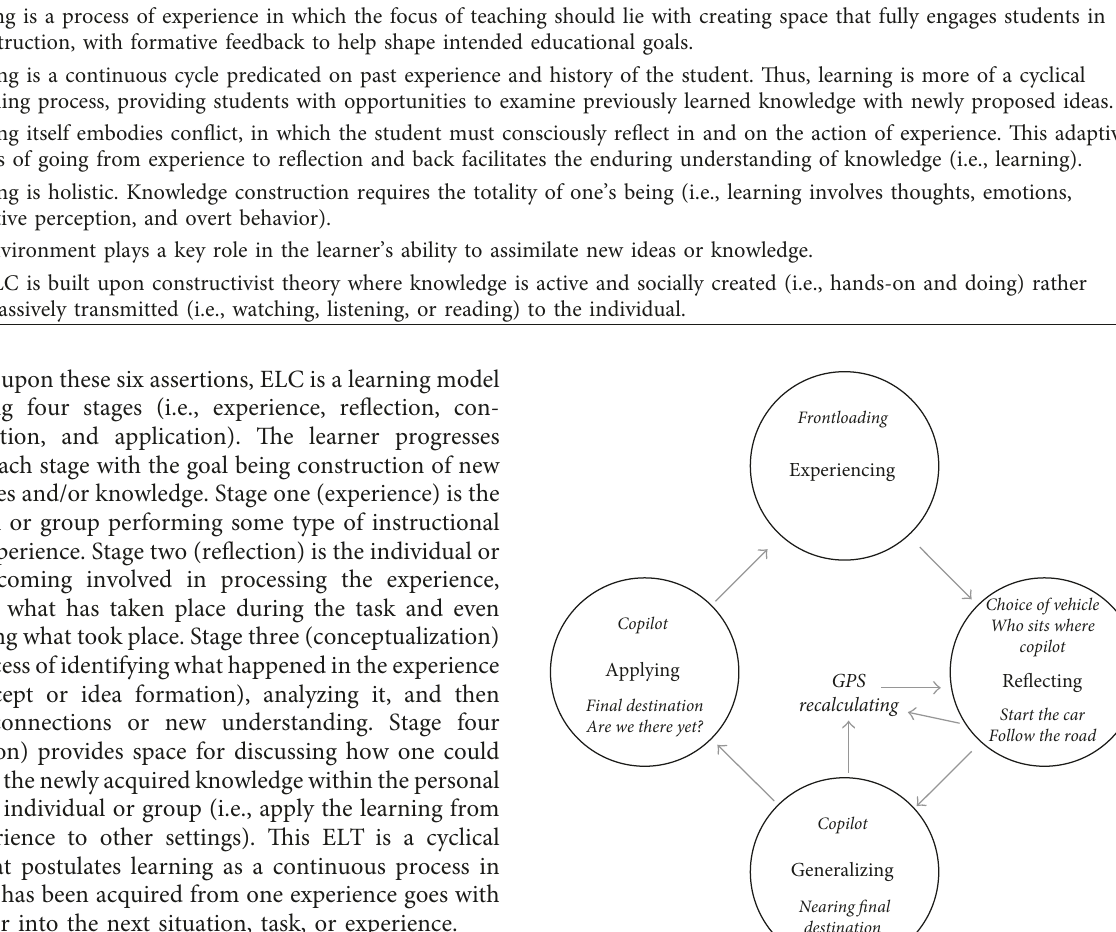
Table 1: Theoretical assertions within the experiential learning cycle (Kolb and Kolb [30]). Leading ELC theoretical assertions